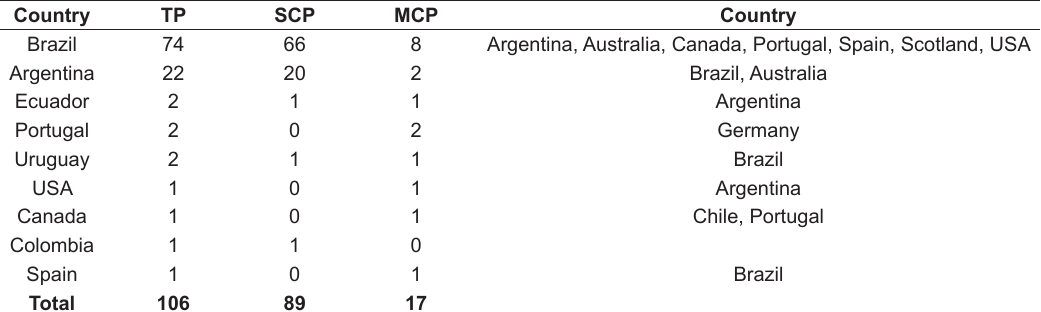
Table 2. Countries (first author) that published studies about decomposition in subtropical South American aquatic environments during the period between 1990 and 2018.